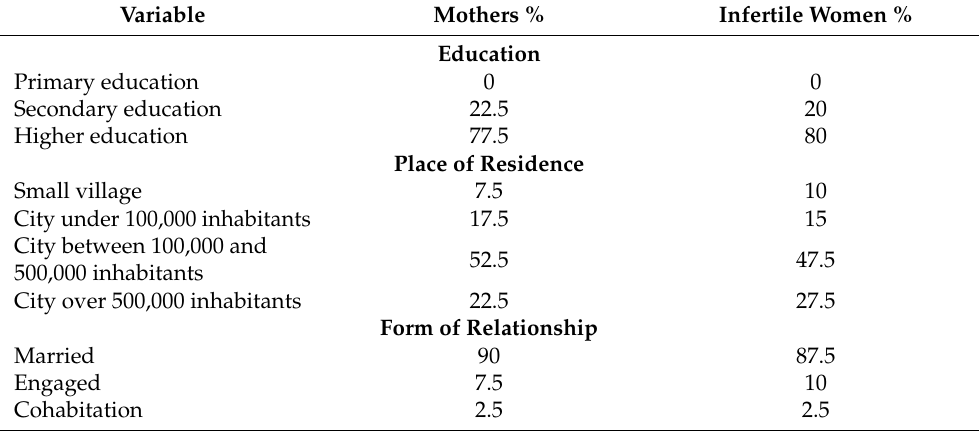
Table 1. Characteristics of the respondents: percentage distribution of sociodemographic variables in the